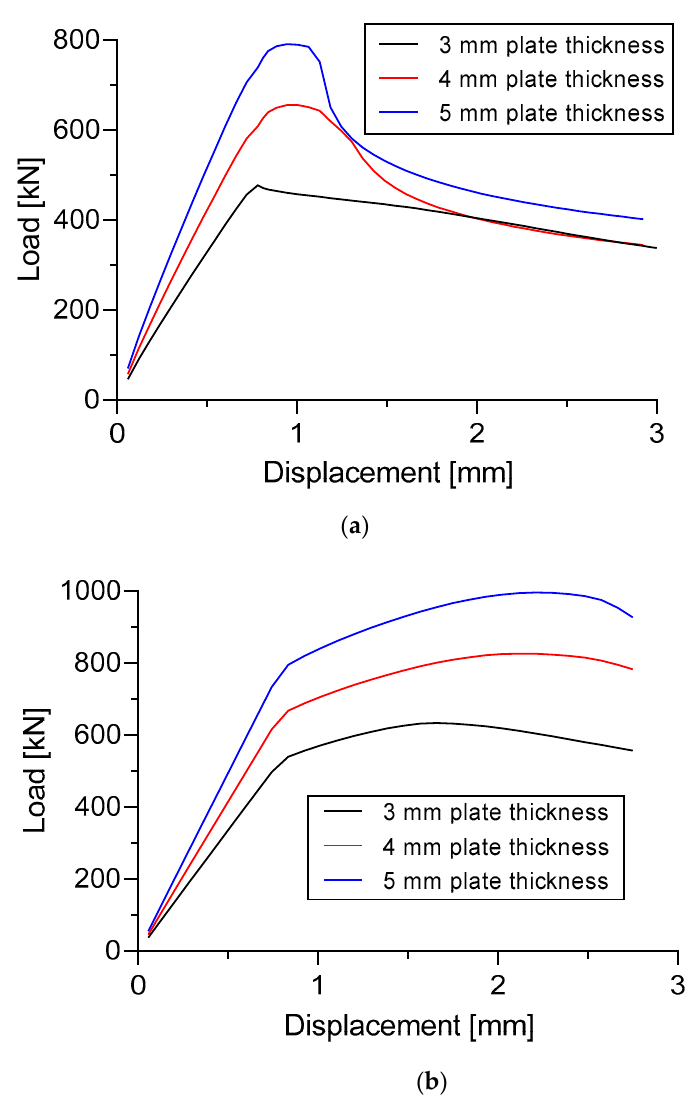
Figure 18. Effect of thickness change to the load versus displacement curve. ( a ) Specimen A; ( b ) Specimen B.